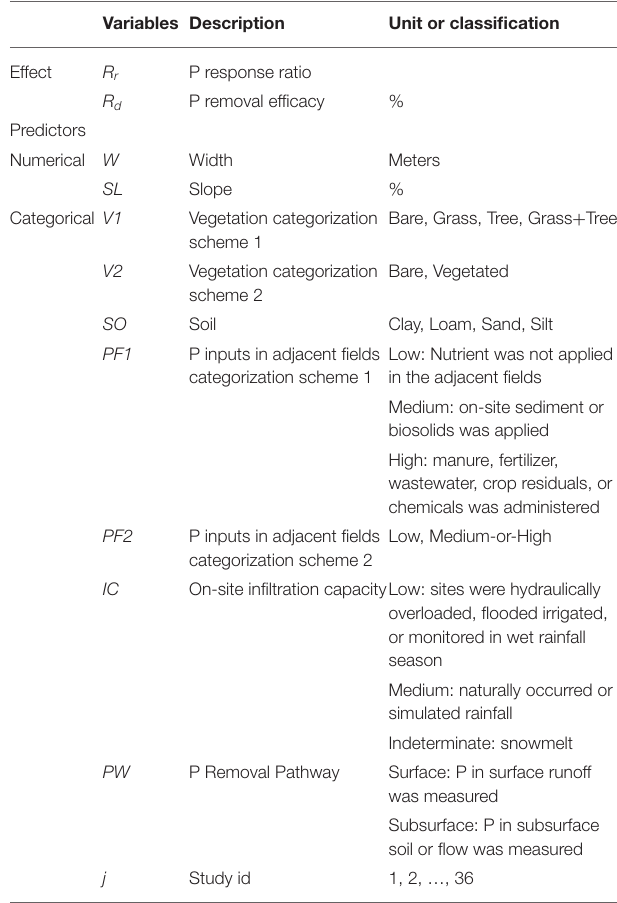
TABLE 1 | Hierarchy of evidence quality. TABLE 2 | Descriptions of the variables used in our